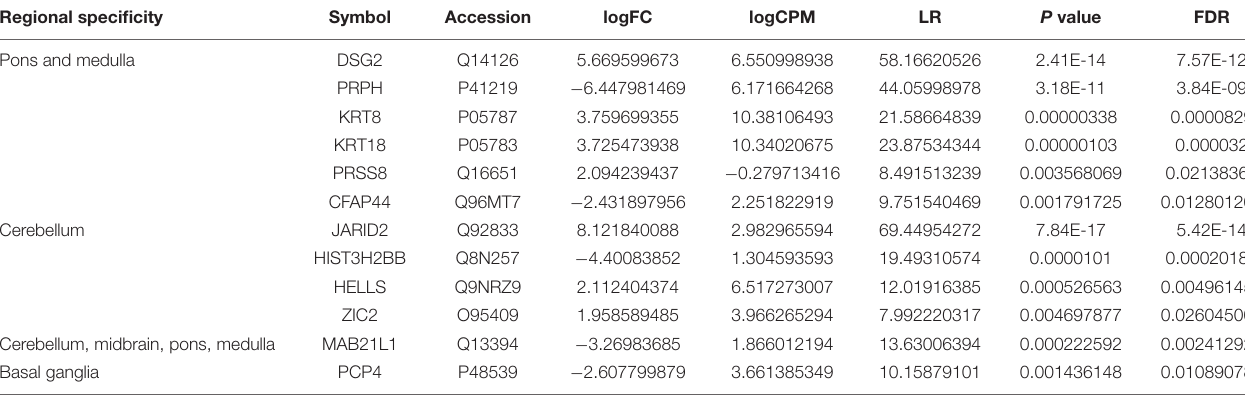
TABLE 1 | Differentially expressed genes specific for brain in mass spectrometric analysis (FDR <